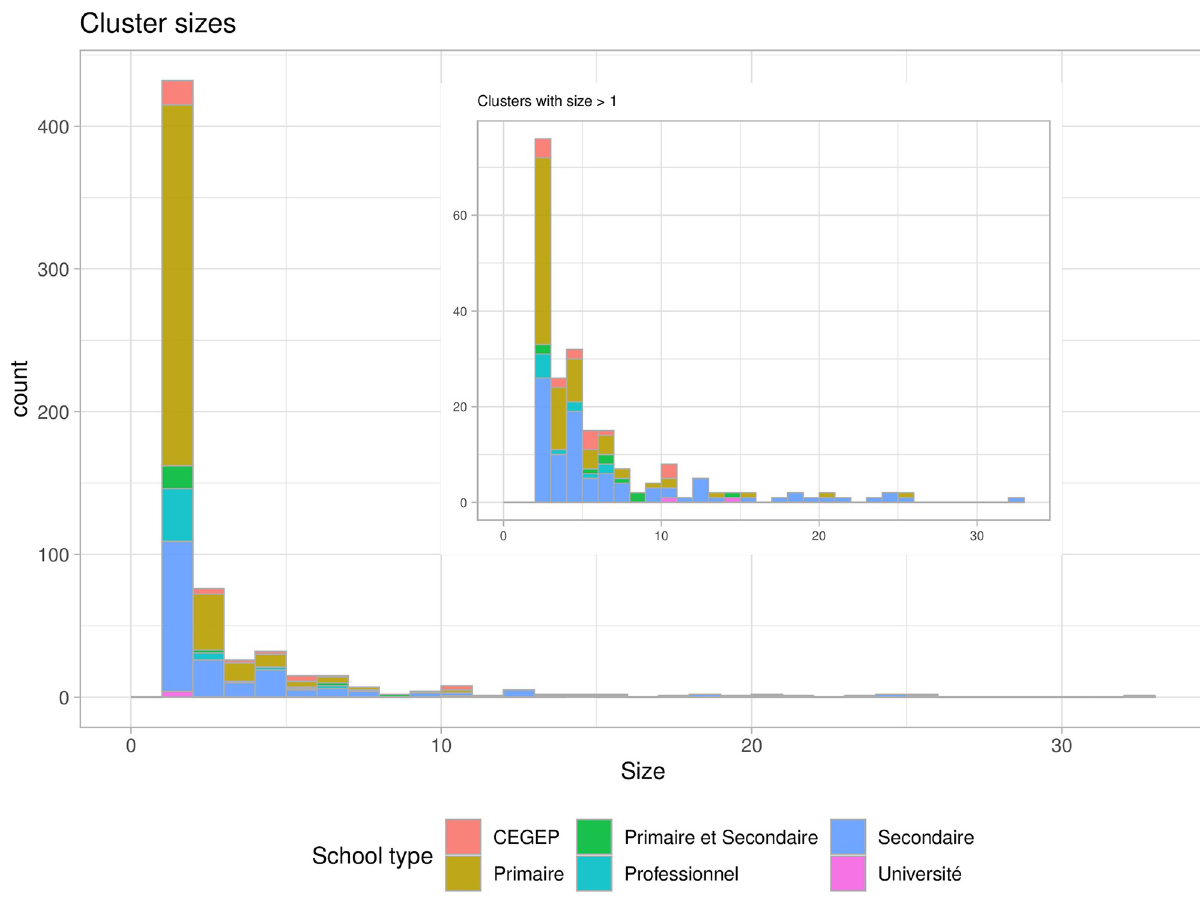
Fig 1. Cluster sizes in Que´bec schools whose exposure was on or before Oct. 01, 2020, as of Oct. 11, 2020. The inset shows only those with 2 or more cases; the main plot shows all exposures. Most exposures have not led to detected clusters; 33% of the exposures have led to at least one additional detected case, and 20% to at least two additional detected